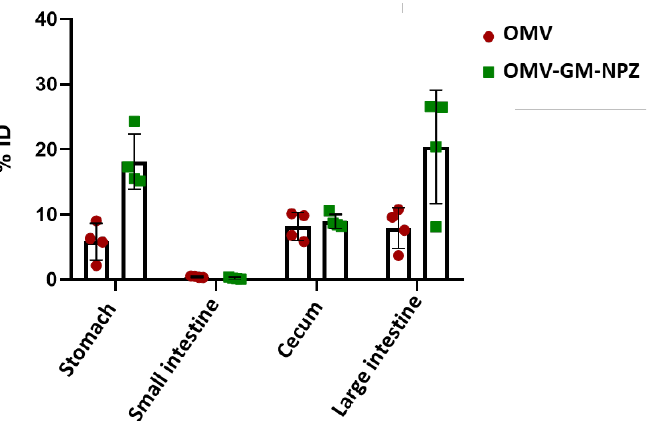
Figure 5. Biodistribution of radiolabeled OMV or OMV-GM-NPZ after oral administration in BALB/c mice. Percentage (%) of 99mTc activity in the different organs 10 h post-administration of OMV (100 μg) or OMV -GM- NPZ (100 μg).